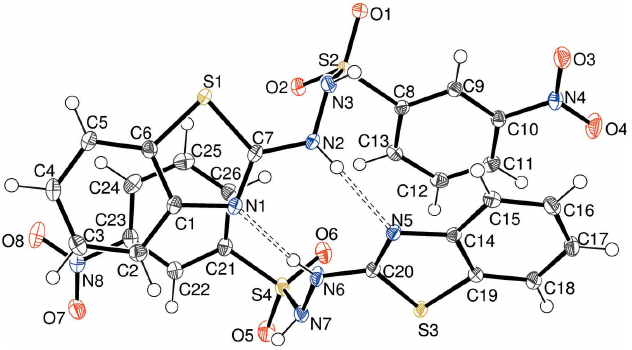
Figure 2 The asymmetric unit of (II) showing 50% displacement ellipsoids. Hydrogen bonds are indicated by double-dashed lines.